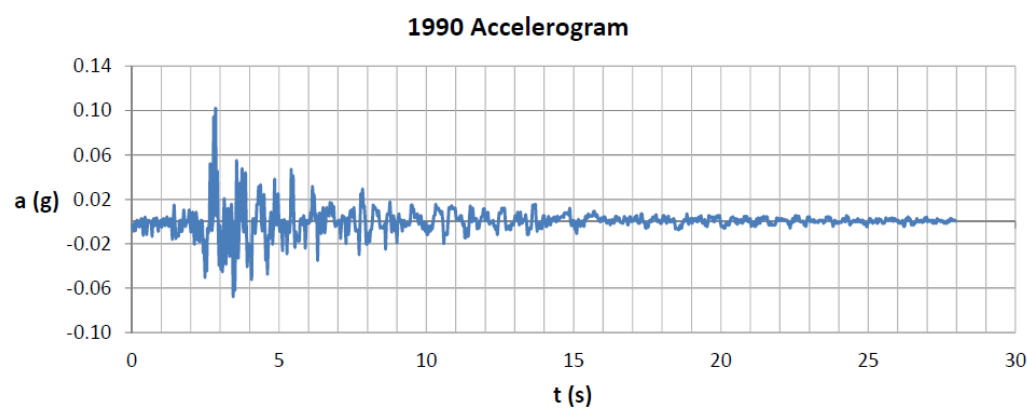
Figure 21. Seismogram of 1693 scaled to the value of 0.350 g corresponding to a return period of 975 years in the actual Italian seismic code [51].